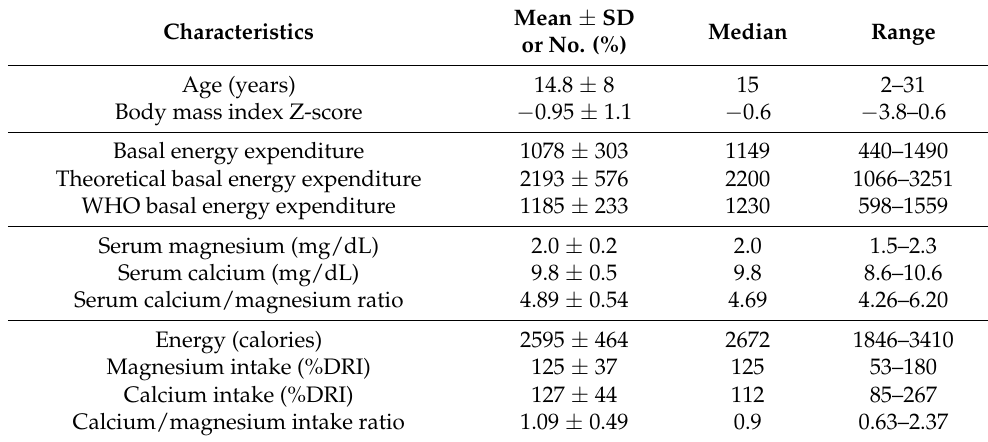
Table 1. Baseline demographic and clinical characteristics of participants ( n = 17 *)